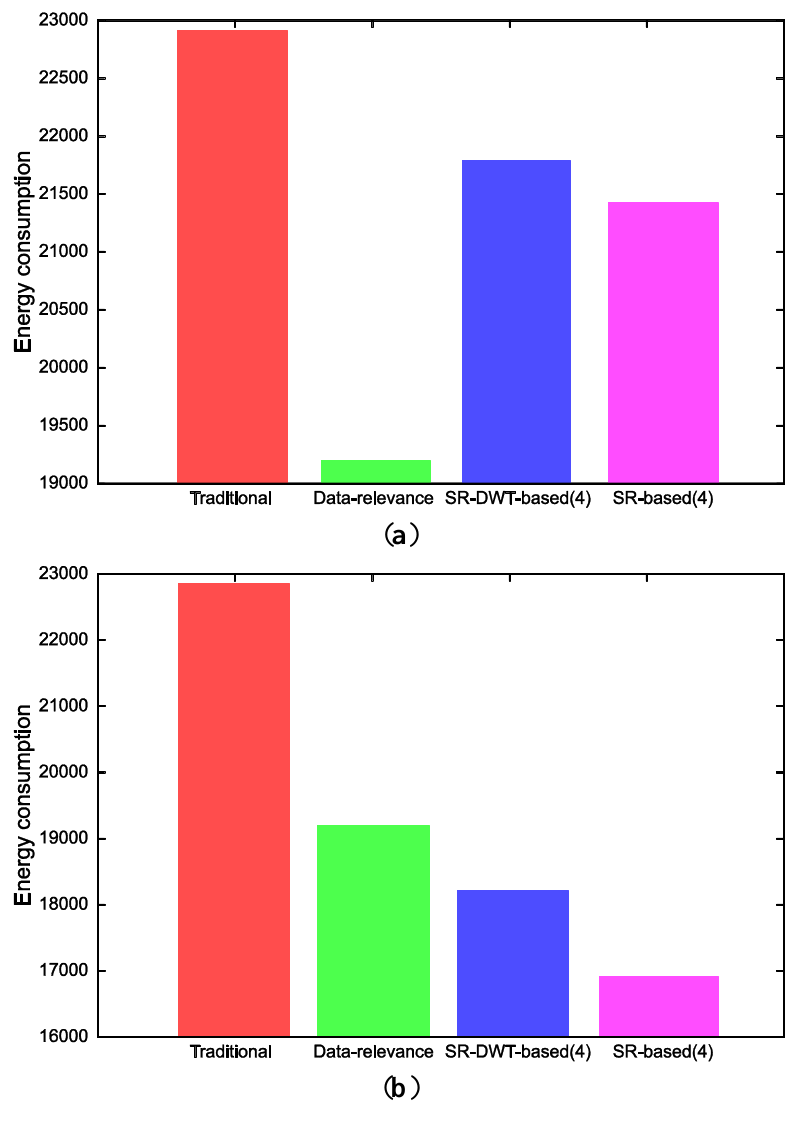
Figure 11. Energy consumption after 12 days. ( a ) e e = 0.8 and e 2